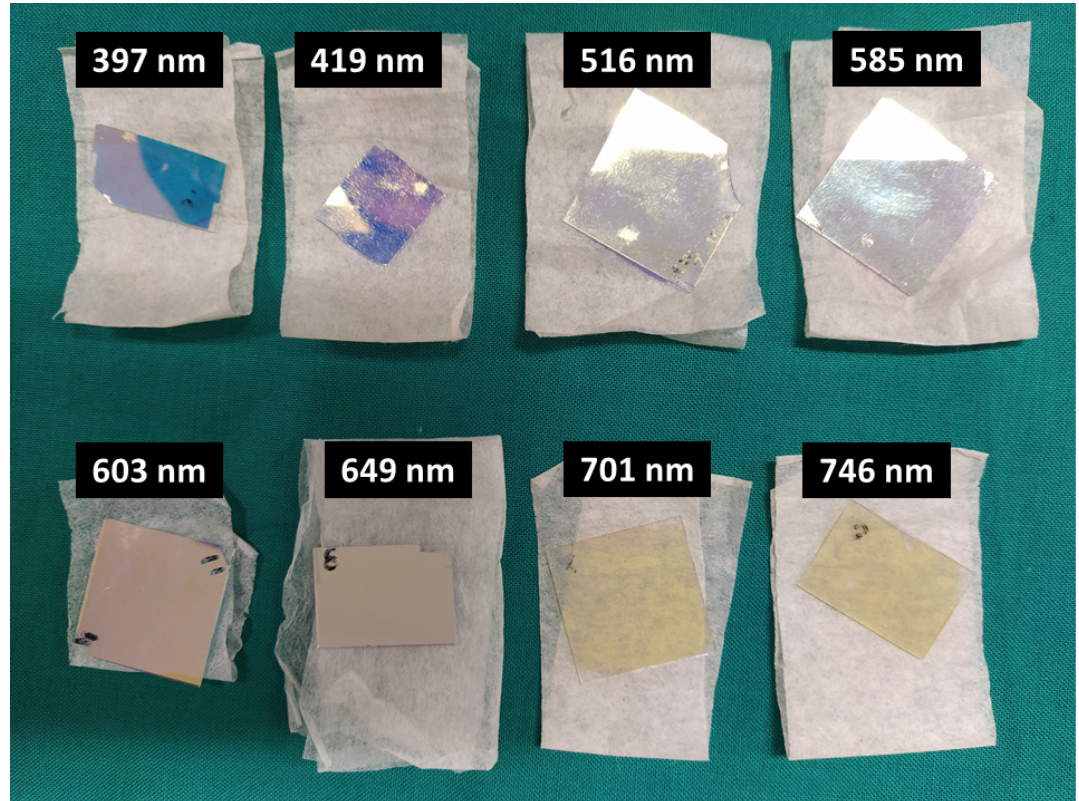
Figure 3. Photographs of the 8 thin-film optical filters experimentally characterized, centred at 397, 419, 516, 585, 603, 649, 701 and 746 nm, used in the experimental assays. In some of the filters, it is clear that some damage of the thin-film surfaces occurred after their prolonged use.